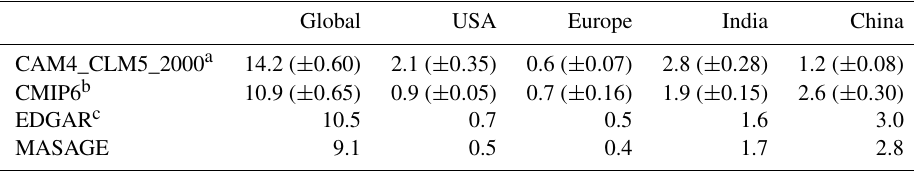
Table 3. Regional fertilizer-induced NH 3 emission totals (TgNyr − 1 ) estimated by our model and reported by other inventories.